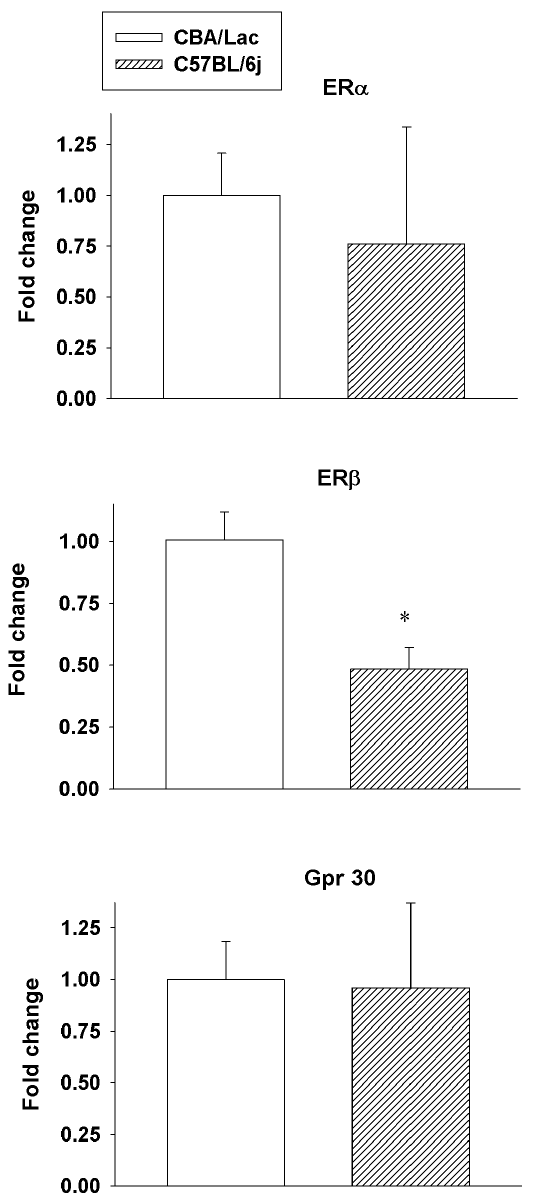
Figure 4. Comparative expression of the family of estrogen receptor genes in Leydig cells from CBA/Lac and C57BL/6j mice. Data are expressed as fold change 6 S.E.M for four independent RNA preparations. *P , 0.05 compared to CBA/Lac.